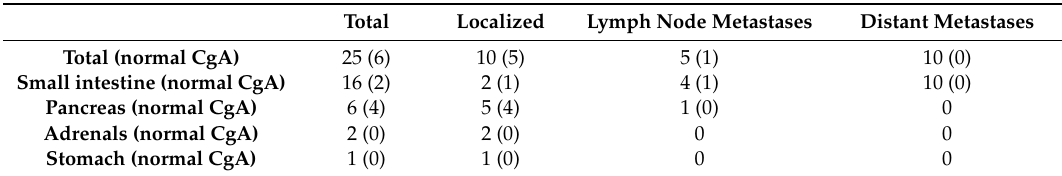
Table 3. NET location and extent of disease. Total number of patients and number of patients with CgA levels within normal range are given.